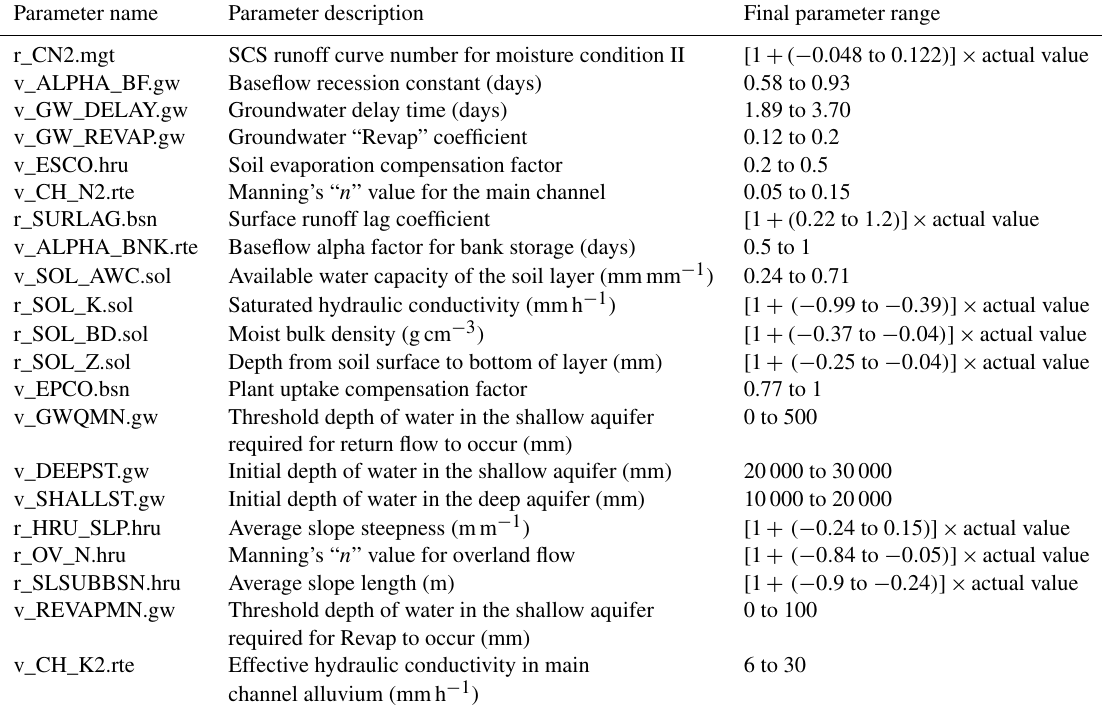
Table 3. Optimised SWAT parameters and their final range.